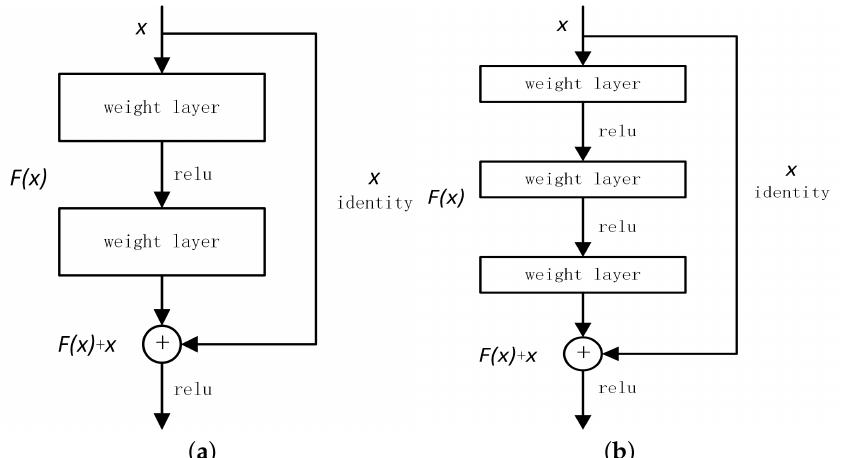
Figure 1. ResNet model residual module: ( a ) the residual module contains two layers; ( b ) the residual module contains three layers.